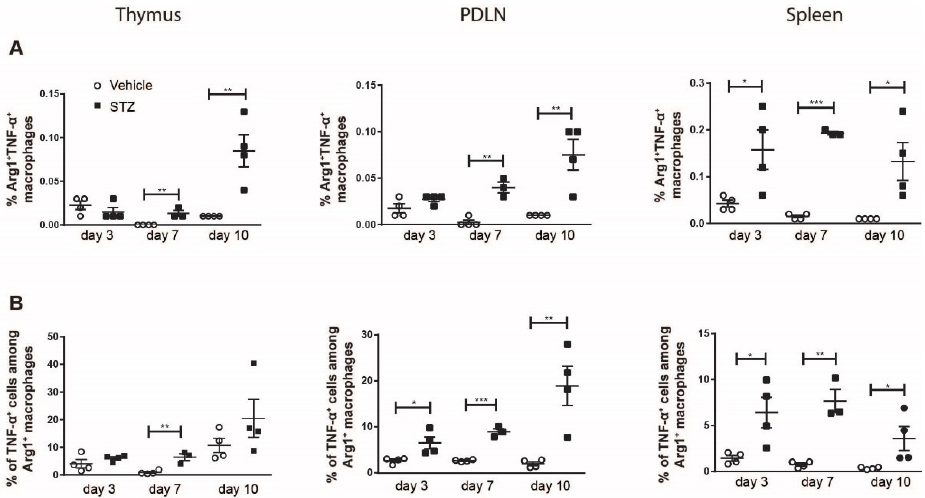
Figure 3. The kinetics of TNF ‐α production in M2 macrophages. Single cells were prepared from the thymi, PDLNs and spleens of vehicle or STZ treated mice. ( A ) The proportions of TNF ‐α + M2 macrophages. ( B ) The proportions of TNF ‐α + cells among M2 macrophages. Results are expressed as means ± SEM. Unpaired t tests were performed for comparisons. *, ** and *** denote p < 0.05, p < 0.01 and p < 0.001.